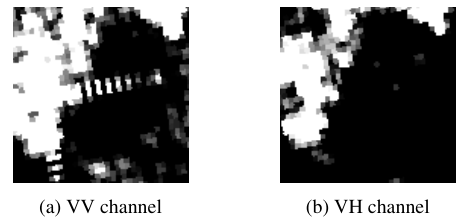
Figure 1. Sinc reflections in the VV channel. Image taken on 2019-12-09.